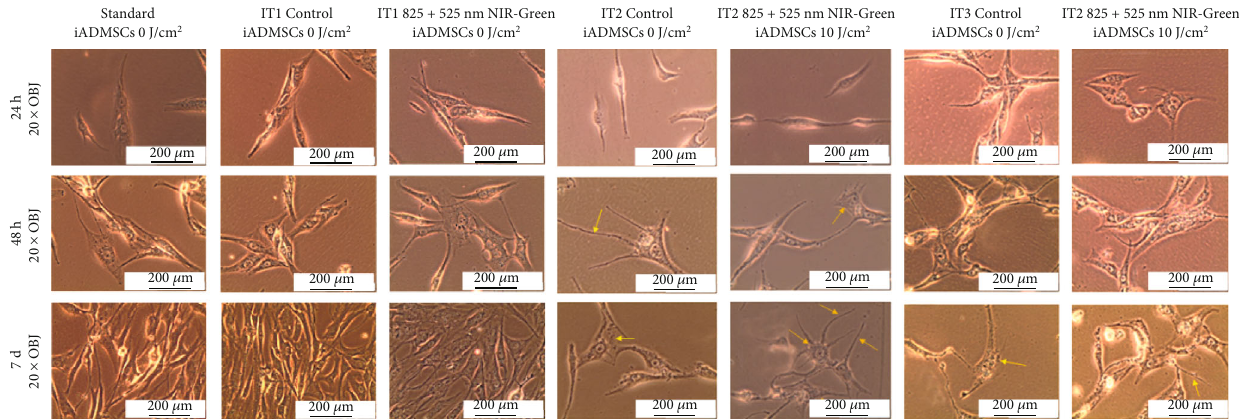
Figure 5: Morphology of transdi ff erentiated iADSCs 24 h, 48h, and 7 days postlaser irradiation. Shown here are the untreated standard iADSCs; untreated IT1 control cells, experimental IT1 iADSCs exposed to NIR-G PBM consecutively, untreated IT2 control cells, experimental IT2 iADSCs exposed to NIR-G PBM consecutively, untreated IT3 control cells, and experimental IT3 iADSCs exposed to NIR-G PBM consecutively. Scale bar: 100 μ